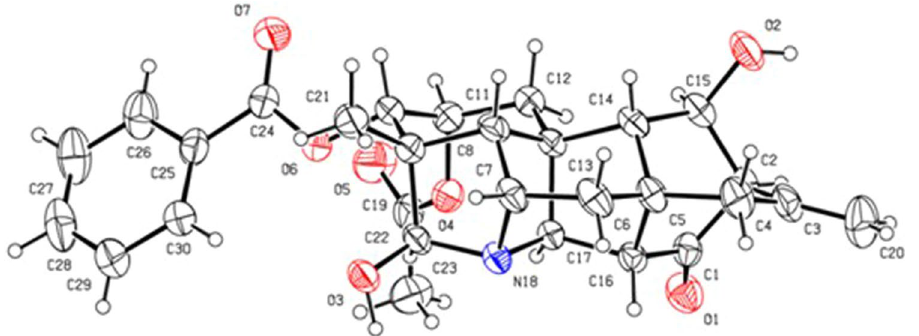
Figure 6. ORTEP projection of compound 11 (crystallographic